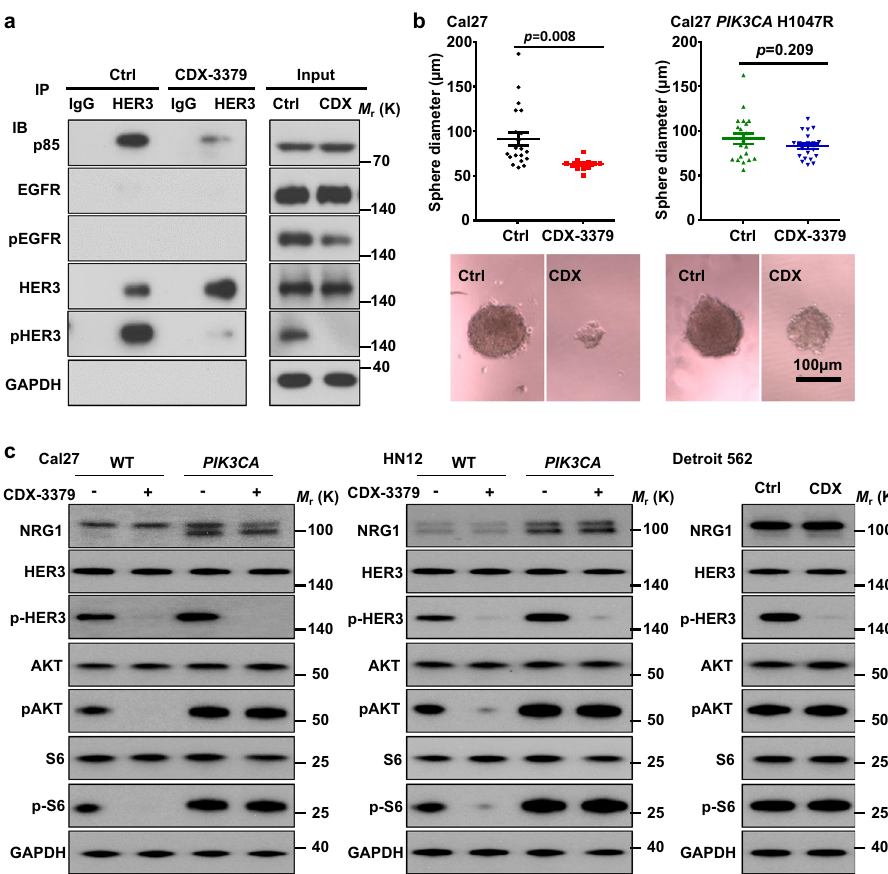
Fig. 3 Anti-tumor effect of HER3 kinase inhibition with CDX-3379 antibody: Disruption of HER3-p85 interaction. a HER3 co-IP analysis of signaling events in HNSCC cells treated by CDX-3379, a HER3 blocking antibody. Cal27 cells were treated by CDX-3379 (1 µ g/ml) for 1 h and cell lysates were analyzed as indicated. b Cal27 cells and cells expressing PIK3CA H1047R were plated in 96-well ultra-low attachment culture plates at 100 cells per well ( n = 20), and treated with PBS or CDX-3379 (1 μ g/ml). The diameters of sphere colonies on each well were monitored using light microscopy. Shown are diameters (top) and representative photographs (bottom) of sphere colonies of each group. (Cal27 control, n = 20; Cal27 CDX-3379, n = 12; Cal27 PIK3CA H1047R control, n = 20; Cal27 PIK3CA H1047R CDX3379, n = 20;). Data were reported as mean ± SEM; two-sided Student ’ s t -test. c Western blot analysis of signaling events in HNSCC cells treated by CDX-3379. Wild-type and cells infected with PIK3CA H1047R ( PIK3CA ) of (left) Cal27, (middle) HN12, together with (right) Detroit 562 cells (harboring PIK3CA H1047R mutations) were serum starved overnight and treated by CDX-3379 at 100 ng/ml for 2 h. Cell lysates were analyzed as indicated. For both Fig. a and c, data shown are representative blots of results from three independent experiments with similar results. Source data are provided as a Source Data fi